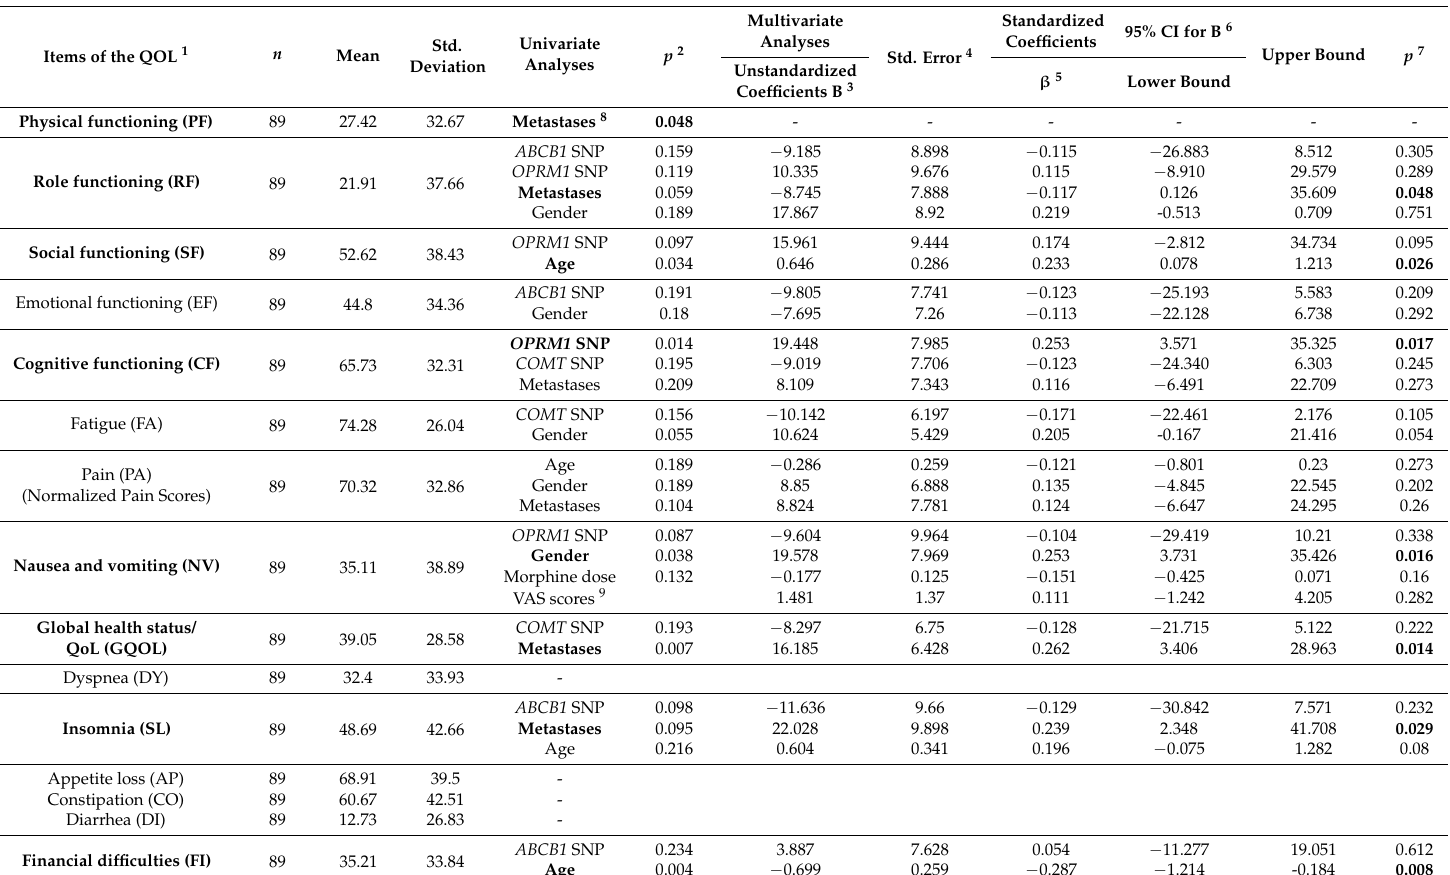
Table 5. Variables associated with the QOL in univariate and multivariate